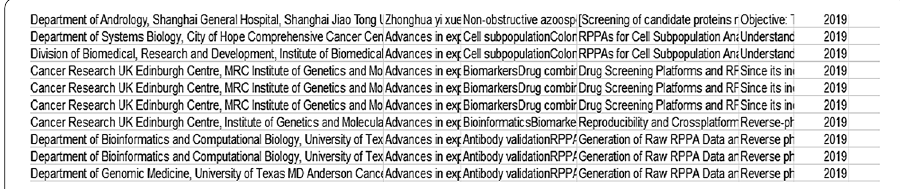
Fig. 2 Extracting and saving the criteria